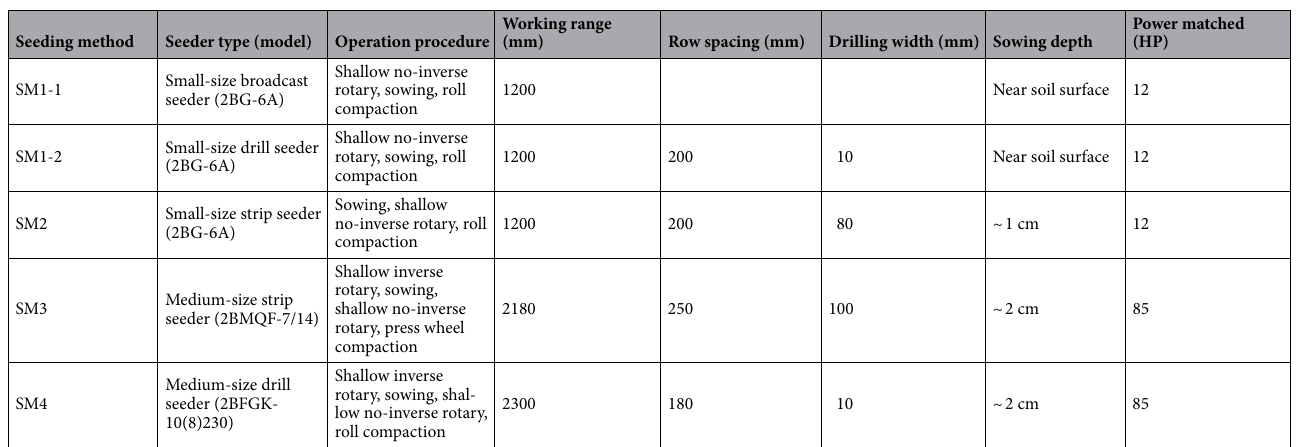
Table 1. Type, operation procedure, and features of the seeders. SM1-1 small-size broadcast seeder, SM1-2 small-size drill seeder, SM2 small-size strip seeder, SM3 medium-size strip seeder, SM4 medium-size drill